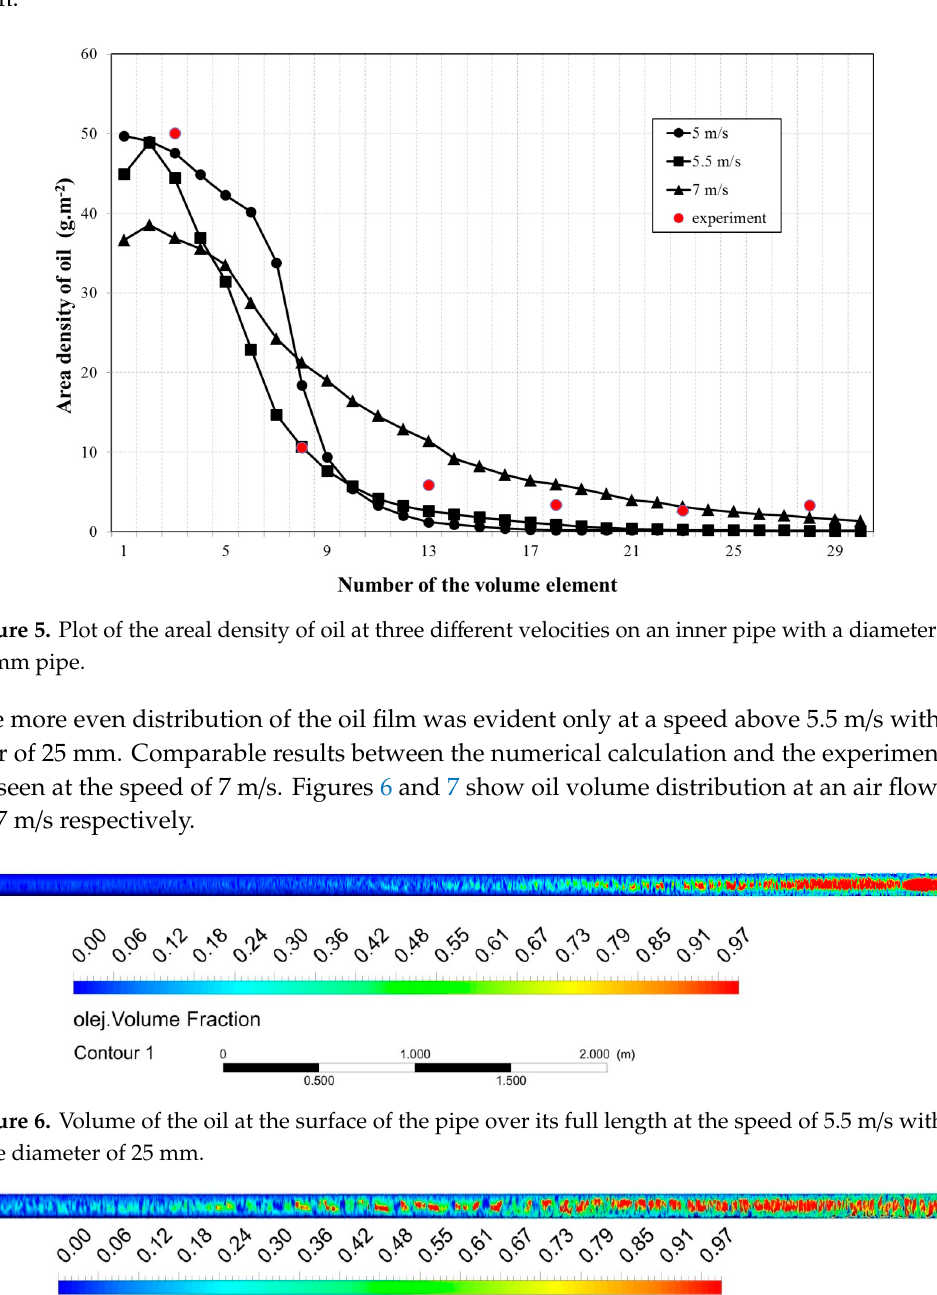
Figure 4. Volume of the oil at the surface of the pipe over its full length at the speed of 5 m/s with a pipe diameter of 35 mm.